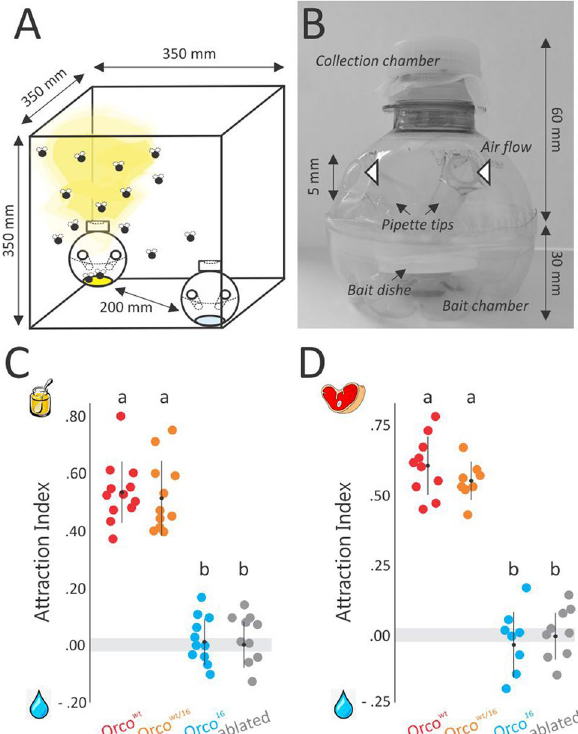
Figure 4. Disruption of ChomOrco impairs foraging and host-seeking behaviors in screwworm. ( A ) Representation of the two-choice trap assay arena. Odor (yellow mist) and control traps are offered to groups of flies at opposite sides of the cage. Groups of 15–25 flies (fasted adults of 3-to-4-days-old, sex ratio about 1:1) were tested in foraging trials, while groups of 10–20 flies (fed, matted females of 6-to-9-days-old) were tested in oviposition assays. Attraction experiments were made in replicates ( n = 8 to 12; dots in C , D ). ( B ) Details of the trap model used in two-choice assays (see also Supplementary Methods). ( C ) Honey odors resemble floral nectar, an important nutritional source for screwworm in nature. Orco mutants (Orco 16 ; n = 11) lost attraction to honey, as ablated flies ( n = 9), while wildtype (Orco wt ; n = 12) and heterozygous (Orco wt/16 ; n = 12) flies remain strongly attracted. ( D ) Screwworm females are stimulated to lay eggs on spent larval media in rearing conditions. This bait releases a volatile blend similar to the one found in screwworm-infested wounds. Orco mutants ( n = 8) have severely reduced attraction to the oviposition media when compared to wt ( n = 10) and heterozygous ( n = 8) flies (Supplementary Movie S1). Similar response was observed for ablated flies ( n = 9). The results illustrate that OR-mediated olfaction is necessary for foraging and host-seeking behaviors in C . hominivorax. Bars indicate mean ± SD. Genotypes marked with different letters denote significant deviations of attraction index as given by the two-sample Wilcoxon rank-sum test with continuity correction (significant at p -value <